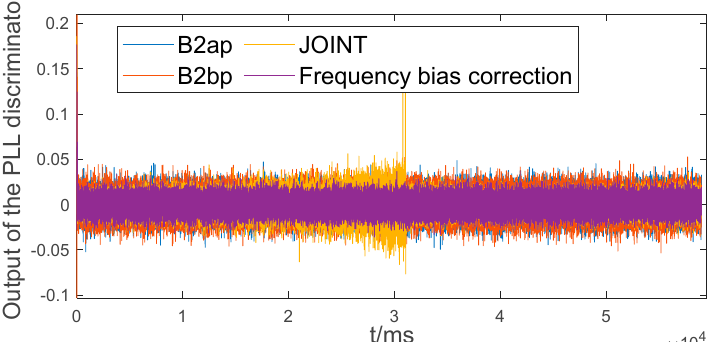
Figure 22. Carrier loop discriminator output before and after frequency bias correction for B2a and B2b signal.